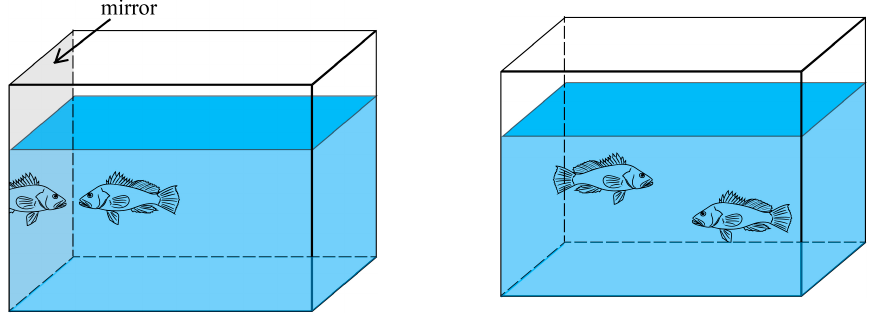
Figure 3. Device used to assess the aggressiveness of black rockfish ( Sebastes schlegelii Hilgendorf, 1880). On the left is a mirror stimulation, in which a mirror is placed on the side of the tank to test the fish’s aggressiveness; on the right dyadic fights are shown, in which the three treatment groups are paired to assess their differences in